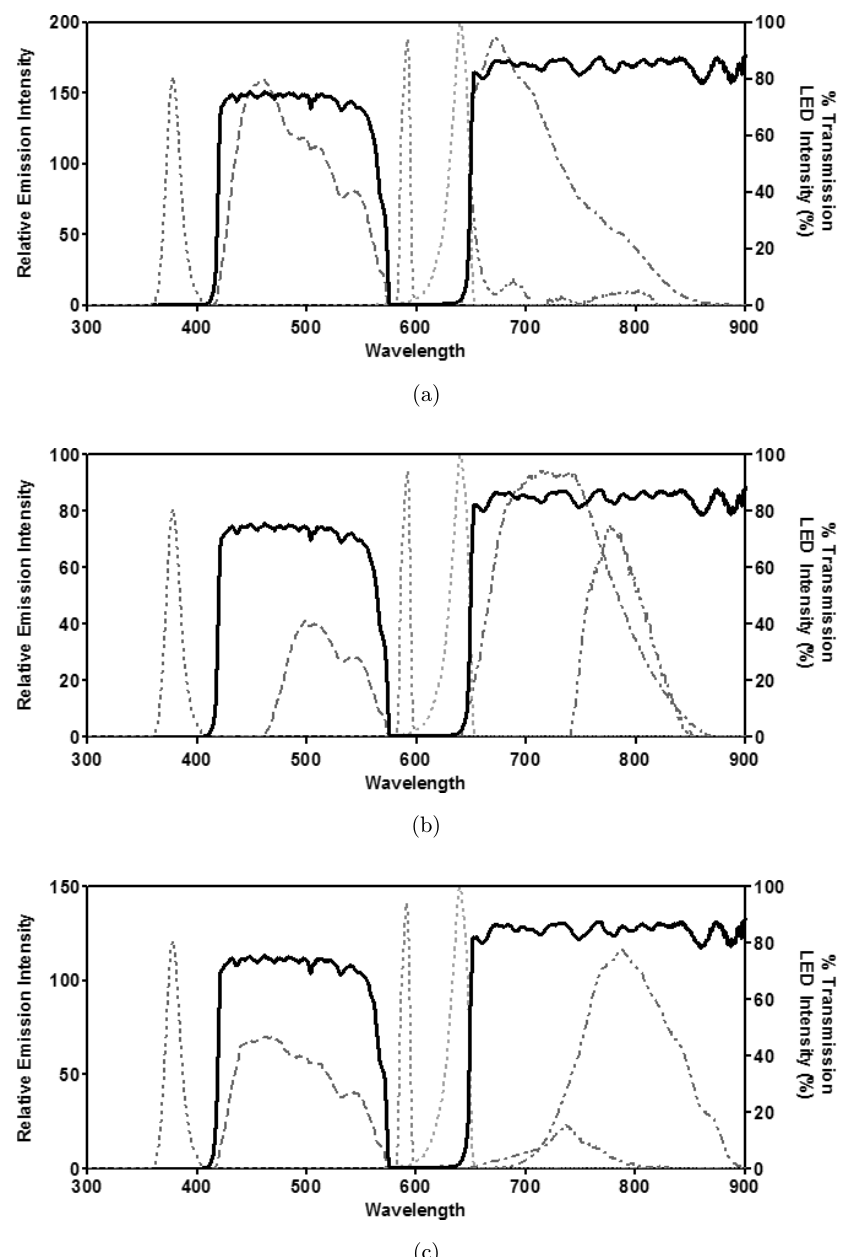
Fig. 2. Spectra for the LED sources, °uorescence bands, and the cut-o® of the excitation rejection ¯lter on the PMT detector for live cells (panel a), dead cells (panel b) and endospores (panel c). The ¯lter characteristics are shown as the solid line and % transmission on the right axis. The three excitation bands are noted as dotted lines. The °uorescence emissions are as follows: 365 nm excitation, dashed line; 590 nm excitation, dashed-dot line; and 635 nm excitation, dashed-dot-dot line.